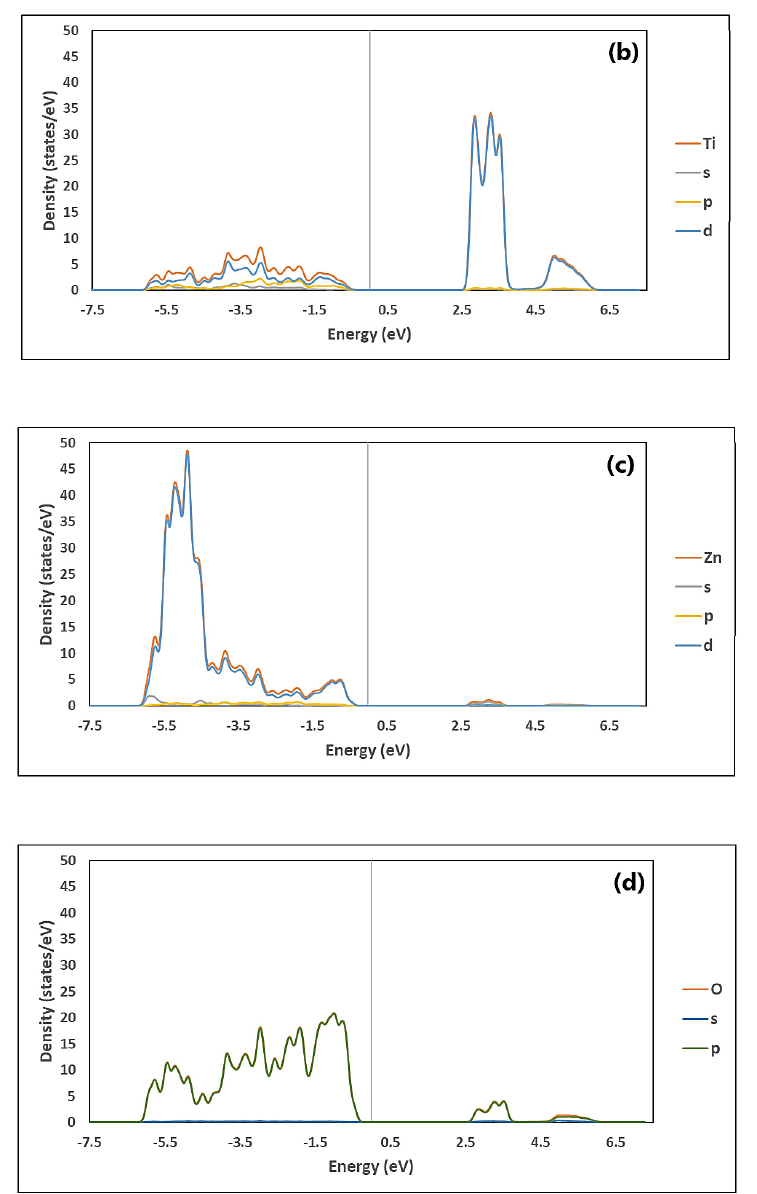
Figure 3. Density of states (DOSs) of ZnTiO 3: ( a ) total, and partial: ( b ) Ti, ( c ) Zn and ( d ) O.